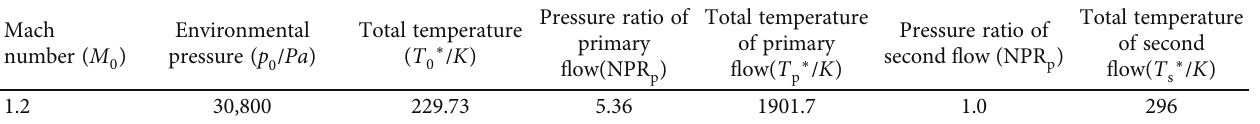
Figure 4: Boundary conditions of the ejector-like nozzle model. Table 2: Values of the corresponding boundary